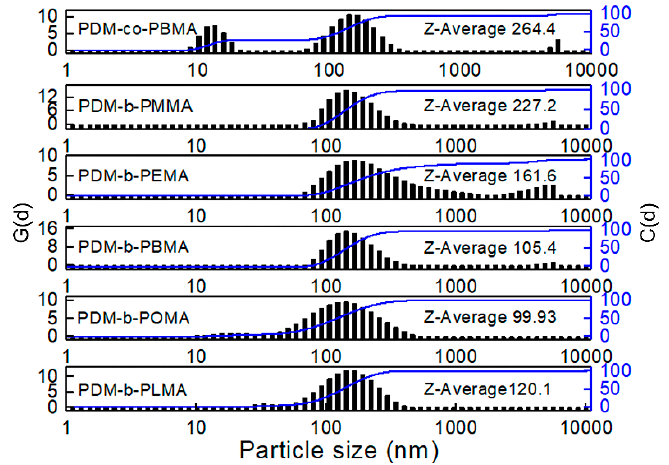
Figure 7. Particle size and distribution of PDM- co -PBMA and PDM- b -PRMA with di ff erent HSC lengths.